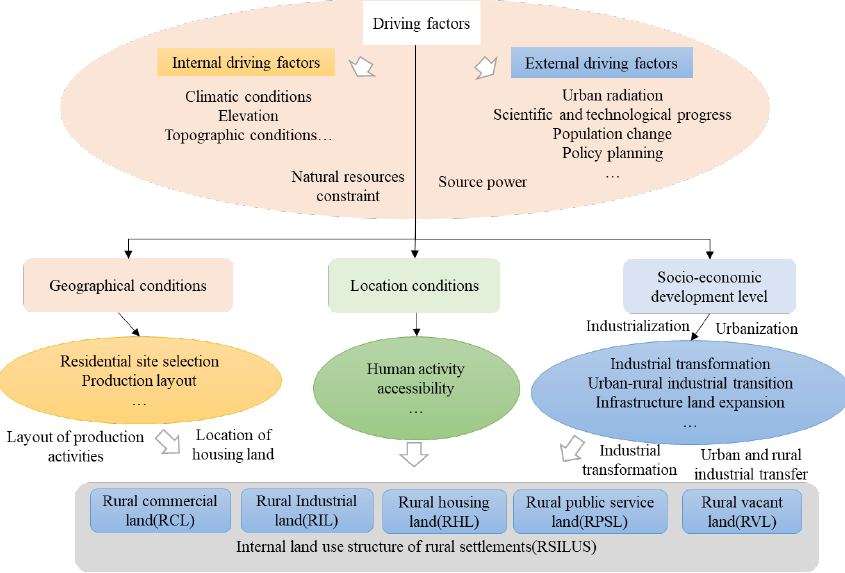
Figure 2. Screening of the influencing factors of the RSILUS.